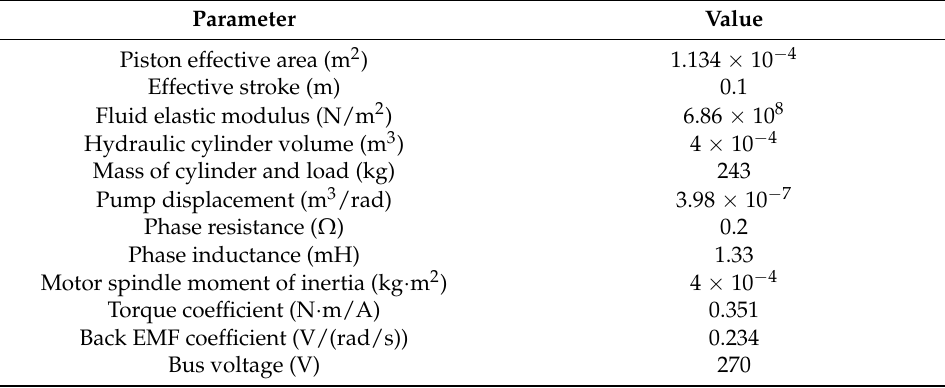
Figure 4. Experimental setup. Table 1. Specifications of the EHA.